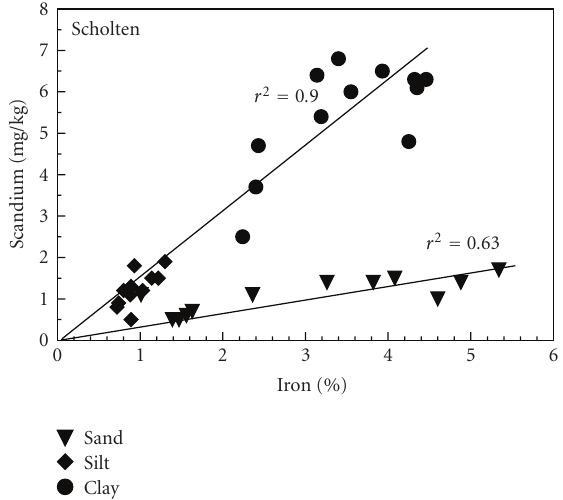
Figure 6: Scandium-iron distribution for the Scholten (Frag- iudults)